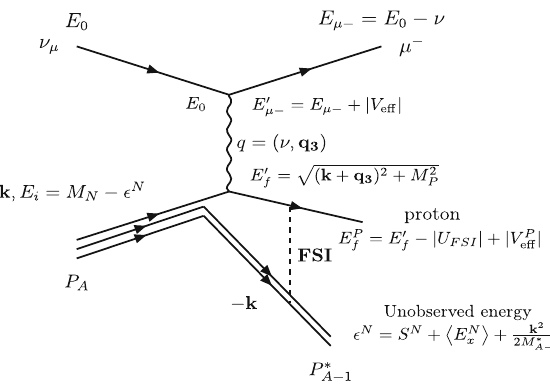
Fig. 22 1p1h process: Neutrino (left) and antineutrino (right) QE scat- tering from an off-shell bound nucleon of momentum p i = k in a nucleus of mass A. The off-shell energy of the interacting nucleon is = M − (cid:2) N , P , where (cid:2) N , P = S N , P + (cid:5) E N , P E N , P N , P i | for neutrino QE scattering on bound neutrons, and the energy | V P ef f